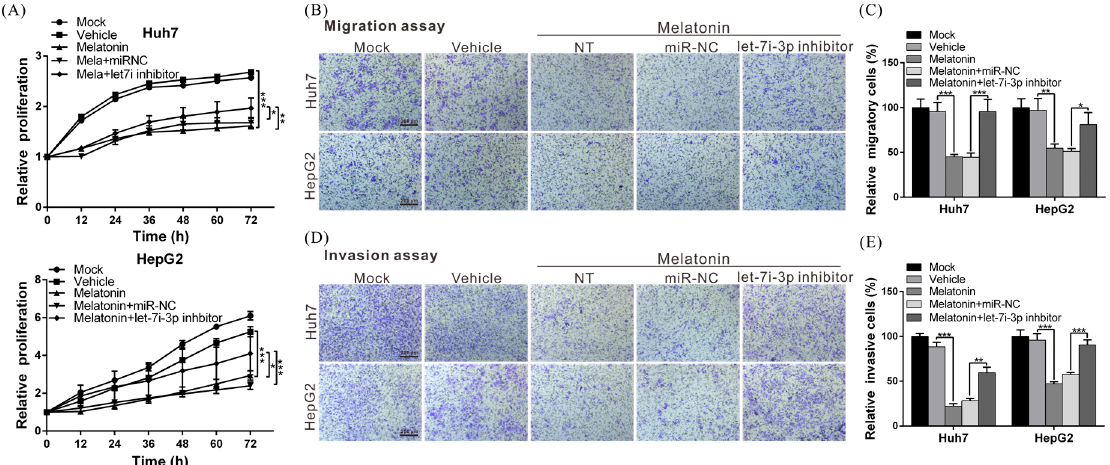
Figure 5. Melatonin exerts its anti-HCC effects through let7i-3p-mediated RAF1 suppression. The inhibitory effects of melatonin on HCC-cell proliferation ( A ), migration ( B , C ) and invasion ( D , E ) were markedly reversed following treatment with a let7i-3p inhibitor. All experiments were performed in triplicate; * p < 0.05, ** p < 0.01, *** p < 0.001. Magnification: 100×. Scale bar = 200 μ m.